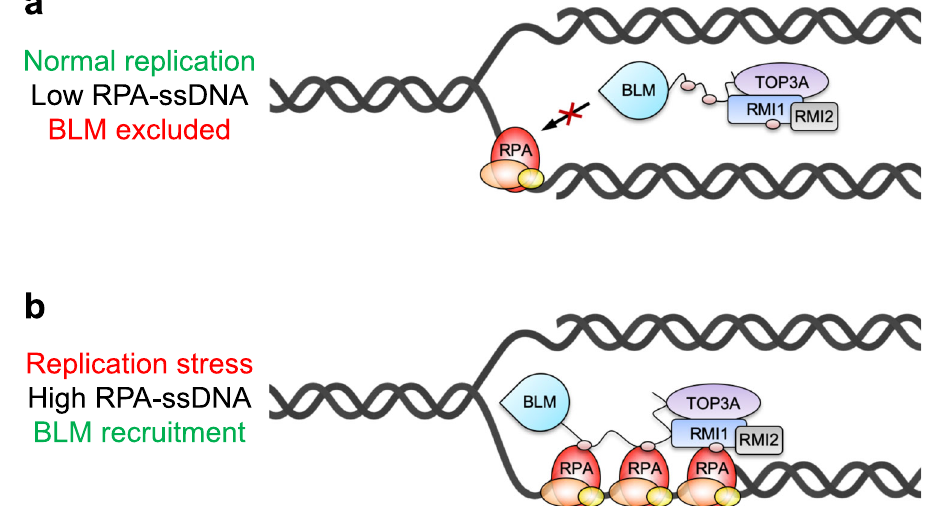
Fig. 6 Model for the role of RPA-binding in speci fi cally recruiting the BTR complex to stalled replication forks. a During normal DNA replication, the BTR complex is not recruited to ongoing replication forks because not enough RPA-coated ssDNA complexes are present. b When a replication fork stalls, increased RPA-ssDNA leads to stable recruitment of the BTR complex and replication fork restart. Gray spheres represent the three RPA-binding motifs in BLM and